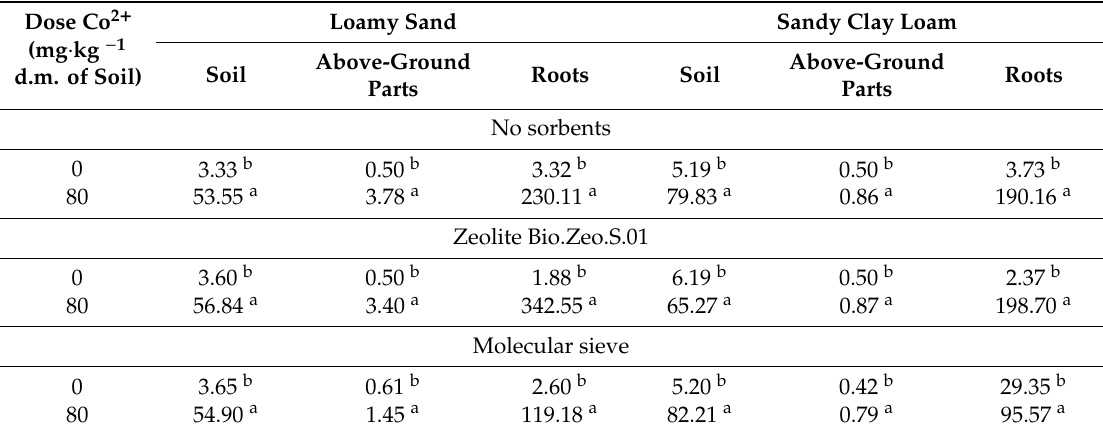
Above-Ground Roots Parts